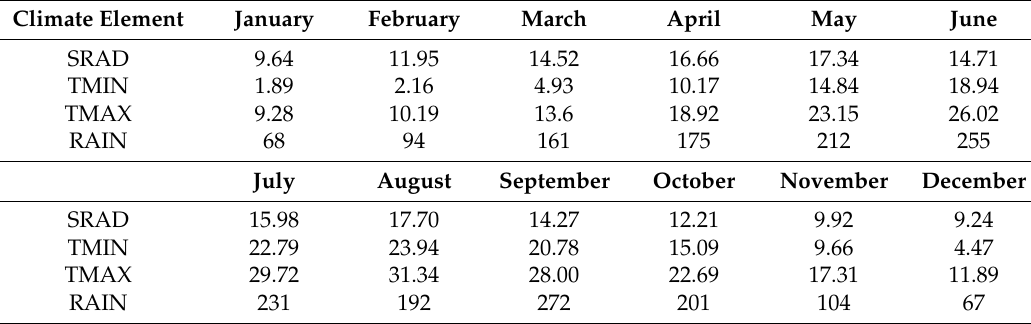
Table 8. Statistical data of climatological data in the study area.